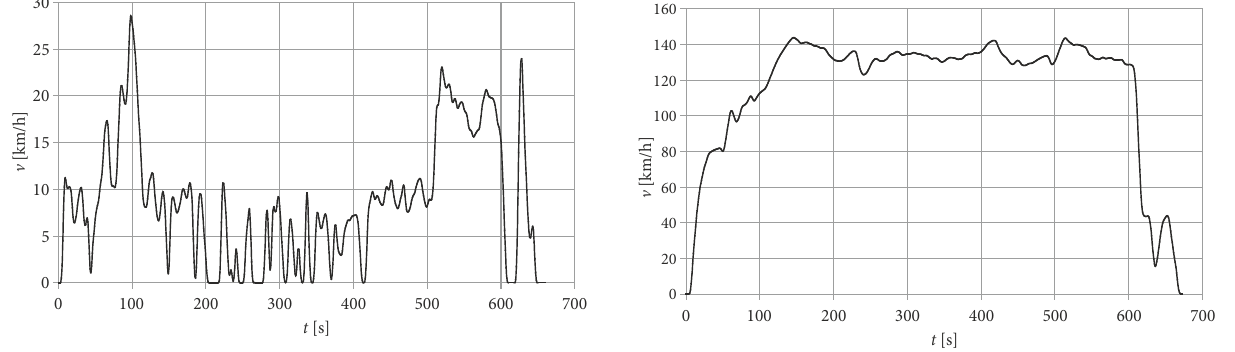
Figure 9. Vehicle speed v vs. time t curve in the HT1 test